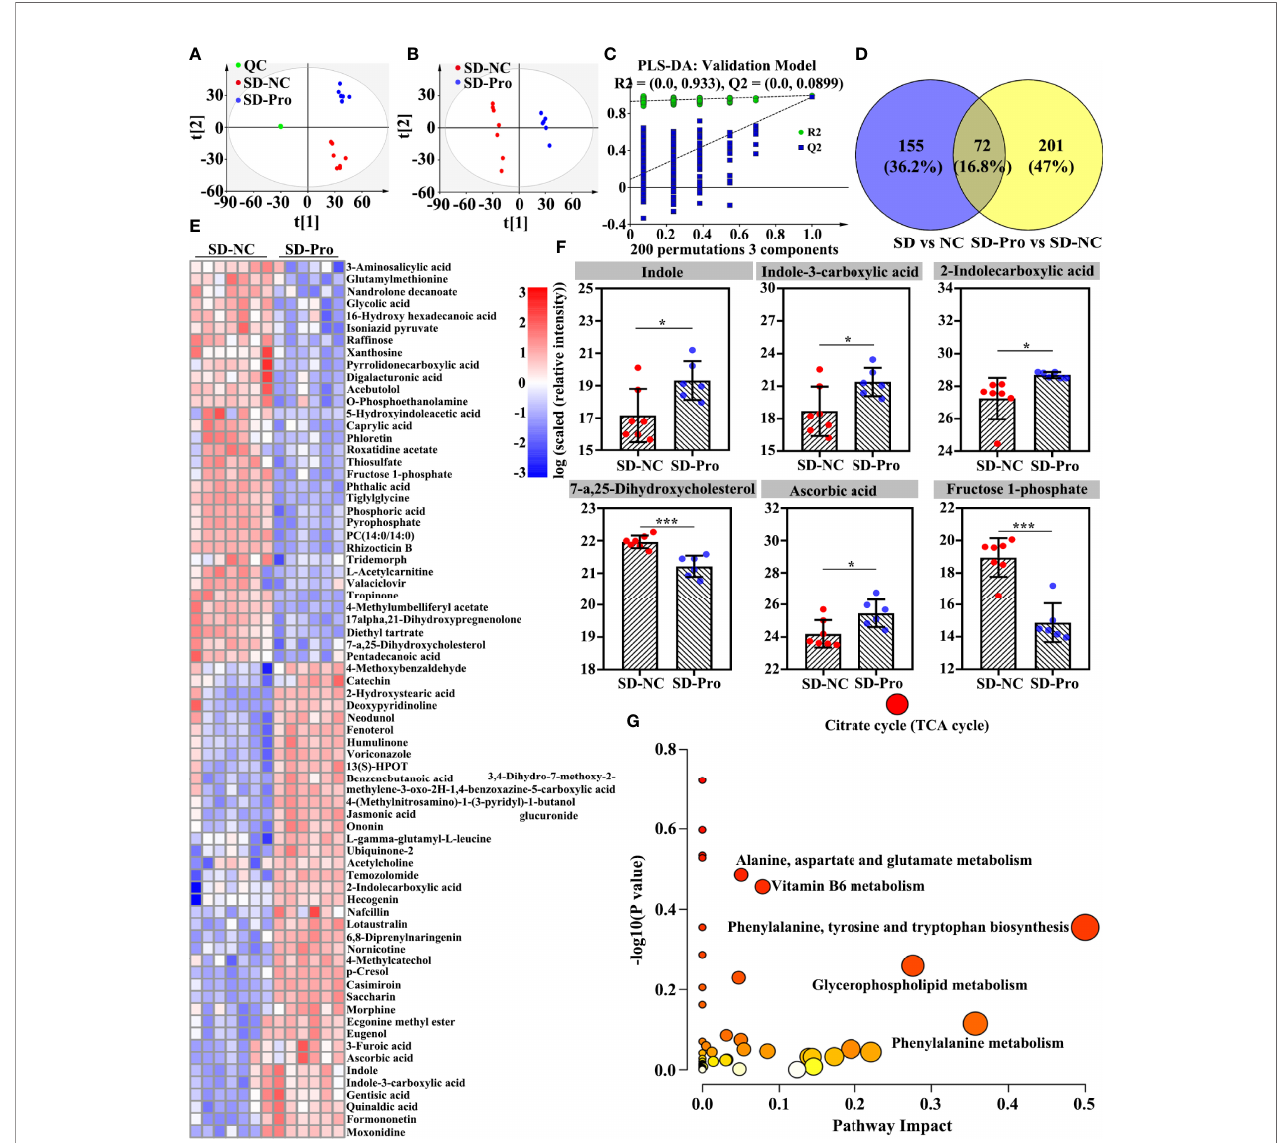
FIGURE 6 | Effects of probiotics supplementation on sleep deprivation (SD) altered gut metabolites in rhesus monkeys (RMs). (A) SD RMs from the probiotics group were clearly separated from those controls in the PCA score plot (5 principal components, R2X = 0.837 and Q2 = 0.570). (B) Metabolites from the probiotics intervention group clustered well away from controls in the PLS-DA score plot (3 principal components, R2X = 0.610, R2Y = 0.999, and Q2 = 0.982). (C) The results of the PLS-DA model were validated by the permutation test [ n = 200, R2 = (0.0, 0.933), and Q2 = (0.0, 0.0899)]. (D) The Venn diagram presented the overlap of differential metabolites between SD and probiotics altered metabolites. (E) Seventy-two gut differential metabolites were changed after probiotics supplementation. (F) The representative of gut differential metabolites was compared and shown using a box map. (G) The involved metabolic pathways following probiotics supplementation. The value of p and pathway impact is calculated from the pathway enrichment and topology analysis, respectively. The node color is based on its p -value and the node radius is determined based on its pathway impact values. Differences were denoted as follows: * p < 0.05; *** p < 0.001. SD-NC, SD control group; SD-Pro, SD group with probiotics supplementation; QC, quality control